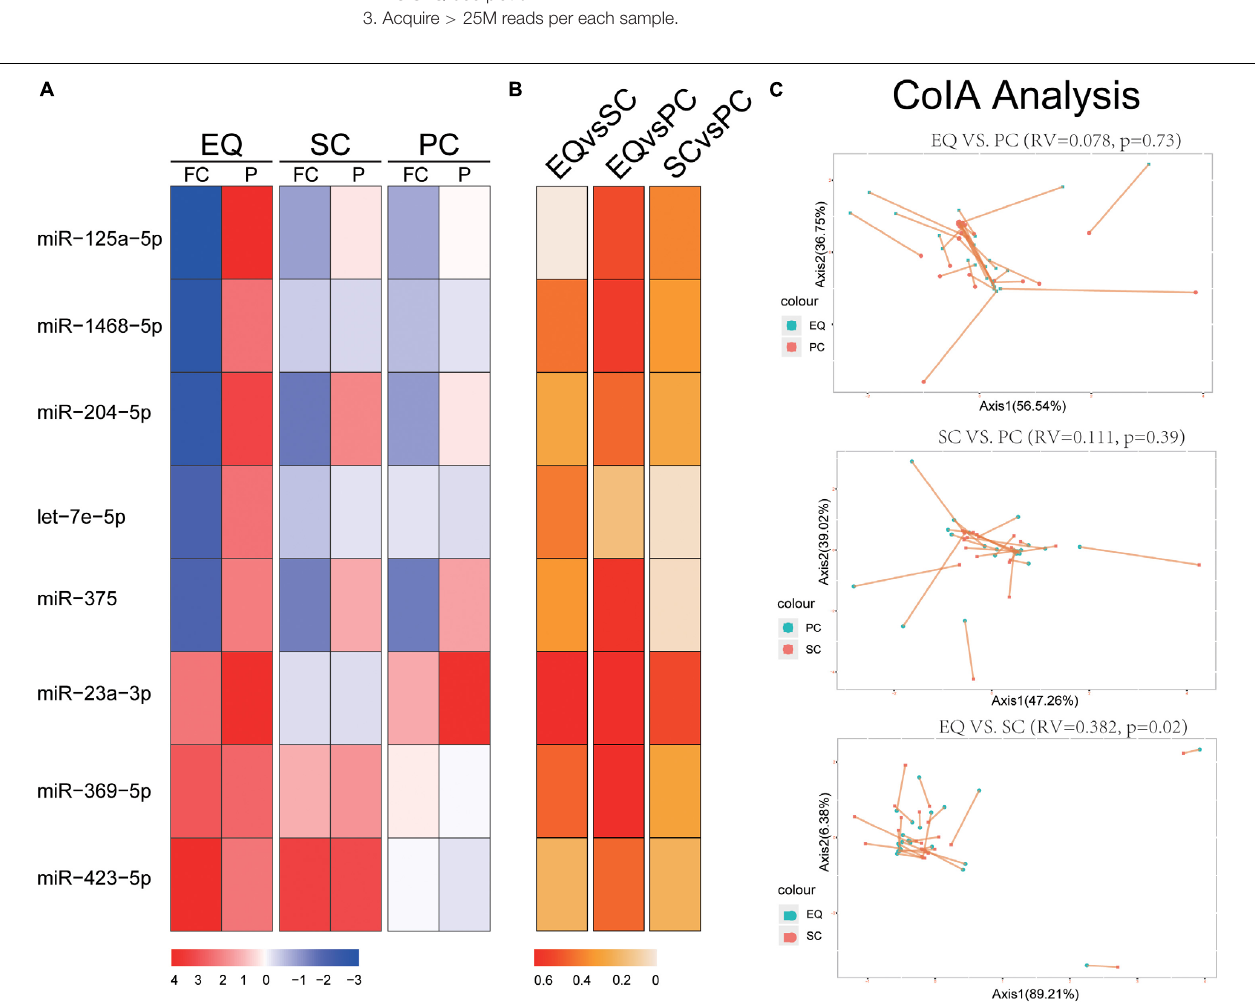
FIGURE 4 | Validation of candidate miRNAs by SC and PC. (A) Fold change (FC) and p -value of candidate miRNA expression in AD samples, FC and p -value were calculated by DESeq2. (B) Spearman Correlation coefficients of miRNA expression between EQ, SC, and PC. (C) Co-inertia analysis of the relationships between EQ, SC, and PC. Monte-Carlo test was carried out, and the significance of correlation could be observed between EQ and SC ( p < 0.05). Each sample is represented with two dots connected by a thin line.